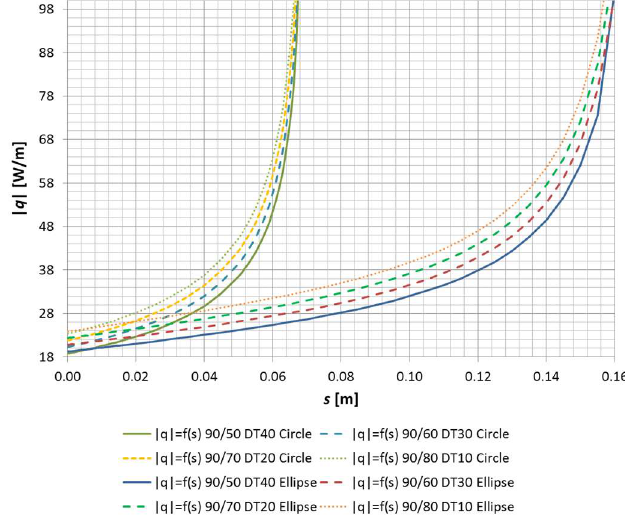
Figure 7. Comparison of the unit heat losses of a twin pipe for thermal circular and elliptic insulation as a function of the distance between the supply and return pipes.